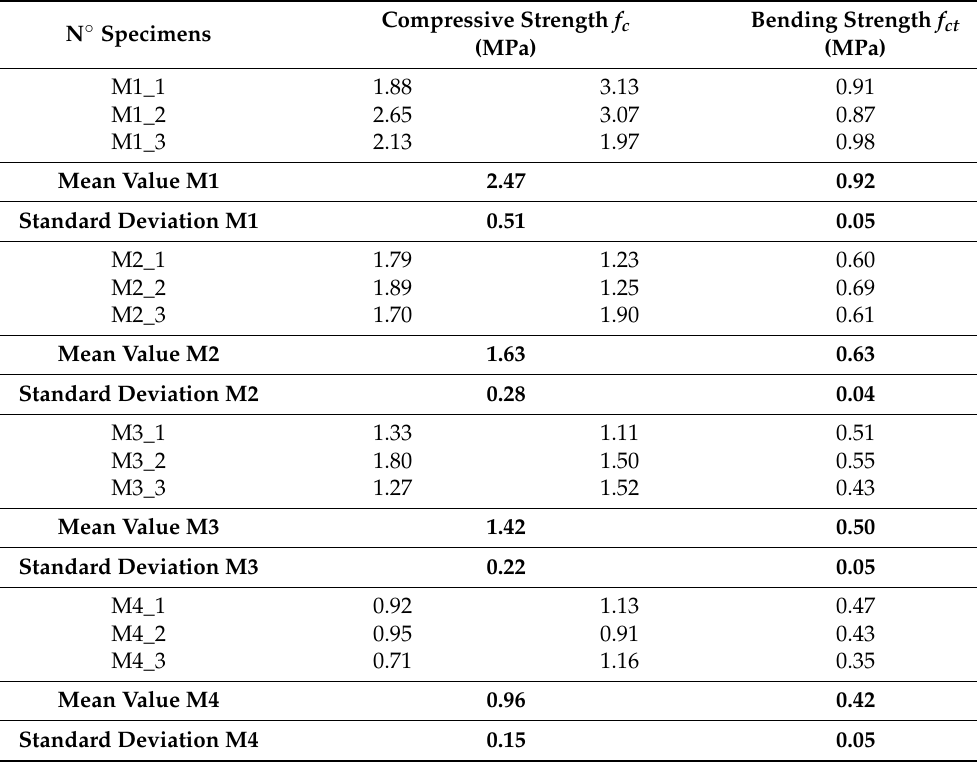
Figure 14. Unconfined compression test on M1–M4 mortar specimens, at the “TecnoLab” labora- tory: ( a ) pre-test; and ( b ) post-test.